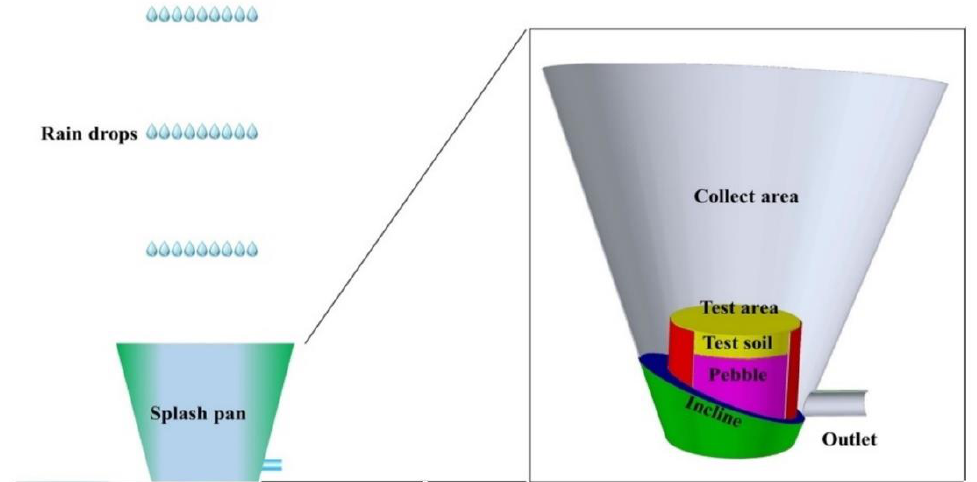
Figure 2. Schematic setup of splash tray used in this experiment.